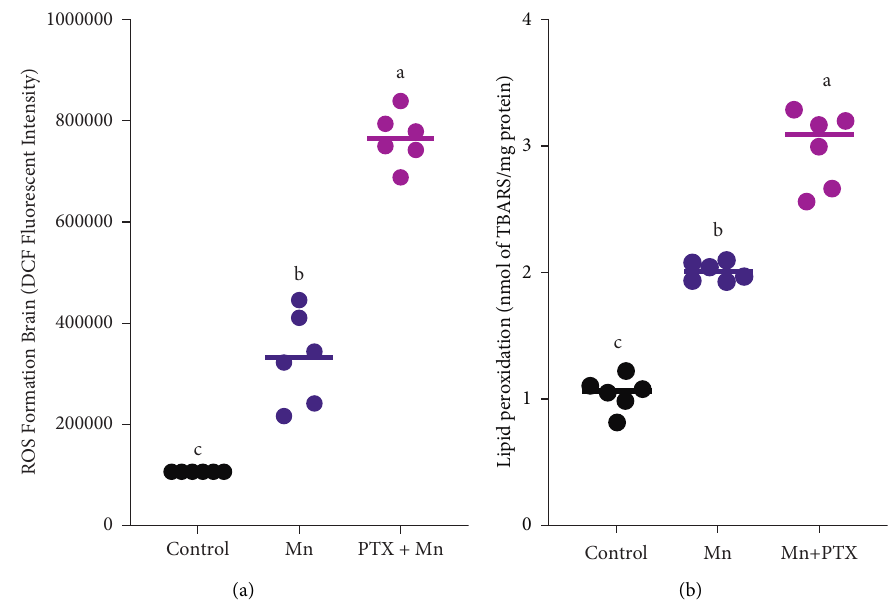
Figure 2: Markers of oxidative stress in the brain of manganese- (Mn-) exposed rats and the effect of PTX treatment. (a) Evaluation of brain tissue ROS formation; (b) assessment of the amount of lipid peroxidation in the brain tissue. Data are represented as mean ± SD. According to the post hoc Tukey test which was used for intergroup comparisons, groups with the same superscripted letters were not significantly different at α � 0.05 ( P > 0 . 05 ) . However, dissimilar letters indicate a significant difference ( P < 0 . 05 )